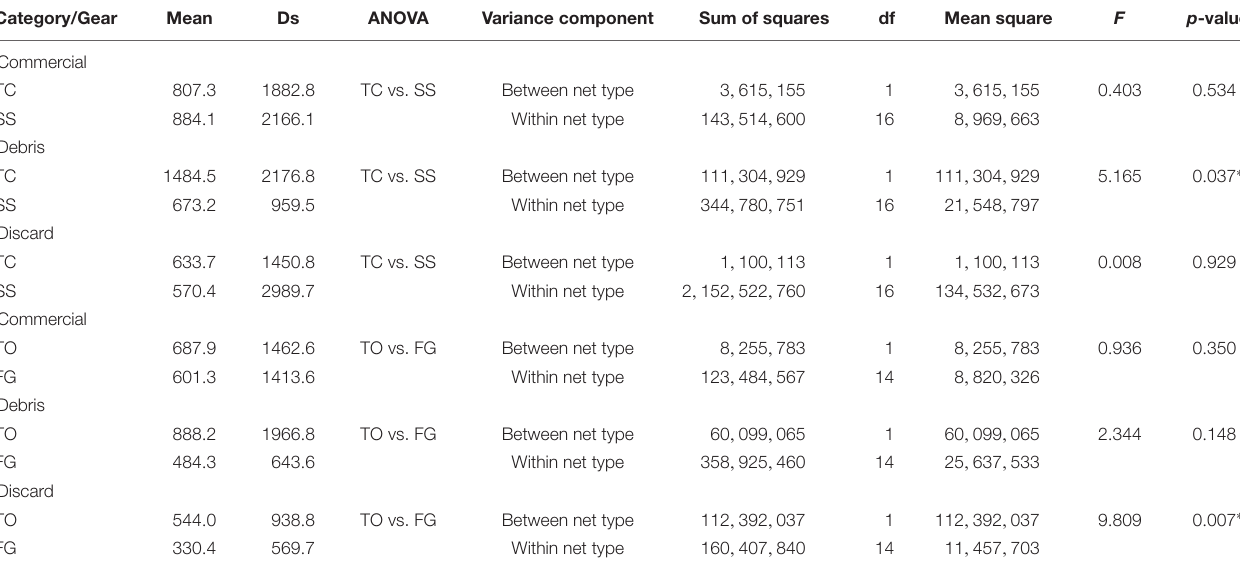
TABLE 1 | Standardized catch (g · h − 1 ) and summary of the One-way ANOVA applied to categories: Commercial, debris, and discard to assess the difference between two types of nets (with and without TED). Category/Gear